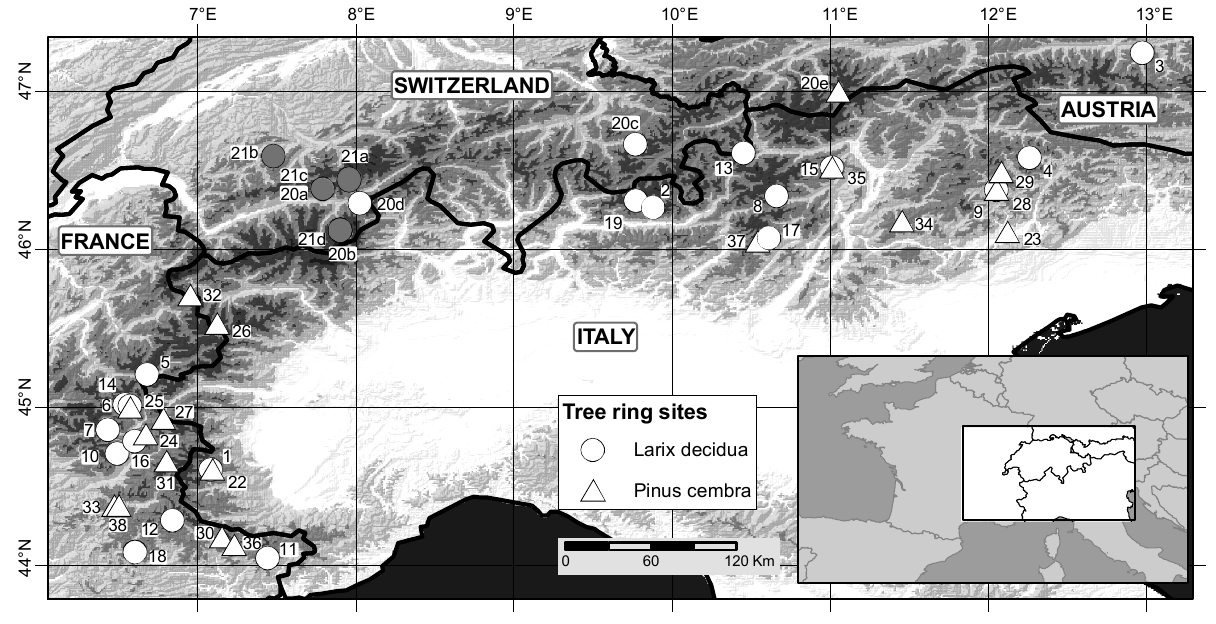
Fig. 1. Location map of the 38 tree-ring sites used for the Alpine temperature reconstruction. Sites are differentiated by species and whether ring-width and maximum latewood density parameters were both available for a site (grey symbol) or only ring-width (white symbol). All tree-ring sites are above 1700m a.s.l. The labelled numbers also refer to Table